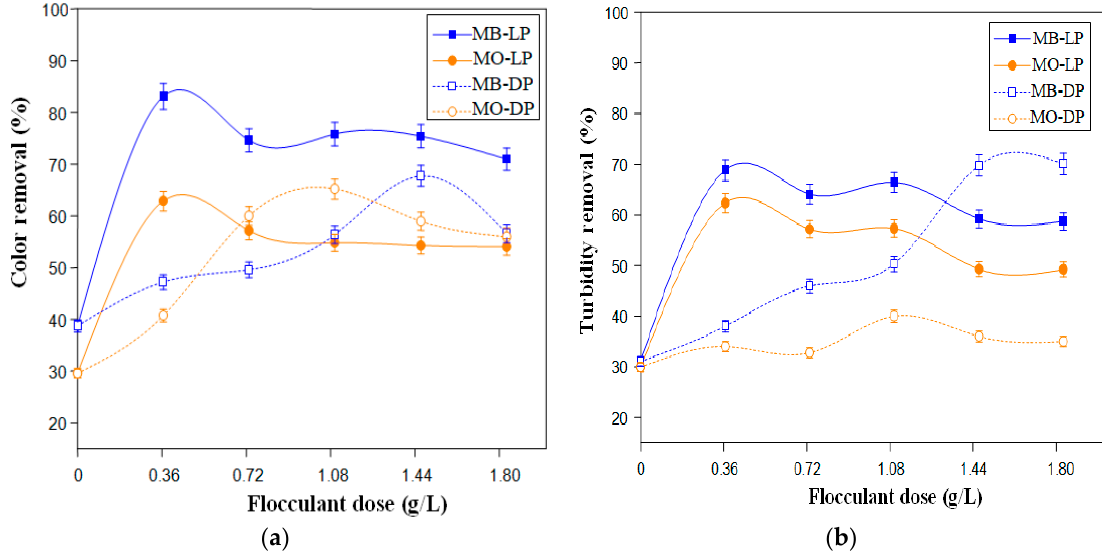
Figure 4. Color ( a ) and turbidity ( b ) removal for MB and MO using the two cactus powders (DP and